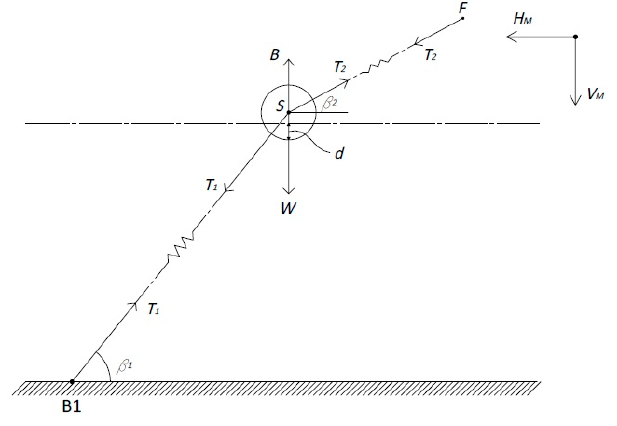
Figure 5. Notation for configuration A.